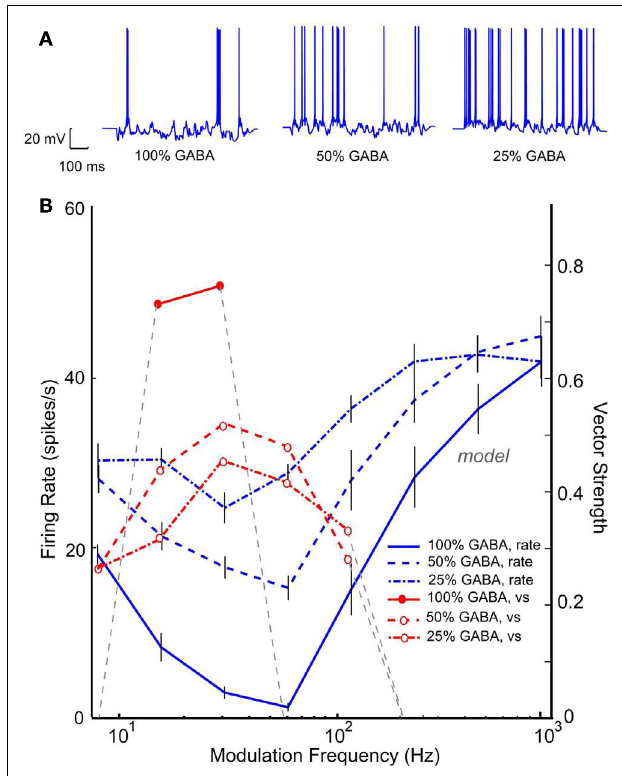
FIGURE 12 | Reduction in band-reject rMTFs due to reduction in GABA A . IC Adapting model with 3VCN inputs and 4VNLL band-pass inputs (rBMF = 32Hz). (A) Example voltage traces from individual trials at 16Hz modulation frequency for a young (left) and aged (right) model neuron. (B) Changes in mean firing rate of a model neuron exhibiting band-reject rMTF ( solid blue ) with reduction in GABA A to 50% ( dashed blue ) or to 25% ( dot-dashed, blue ).The original vector strength ( solid red ) reduced for both conditions ( dashed, red , and dot-dashed red respectively). Firing rate, in spikes/s, and vector strength are marked along opposing Y -axes and modulation frequency is marked along the X -axis in